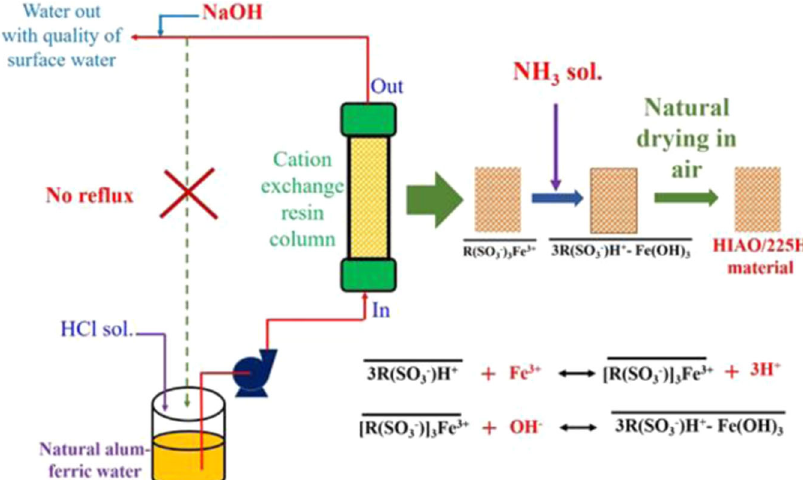
Fig. 8 Process of HIAO/225H material synthesis. A plastic column with a diameter of 1 cm, cation exchange resin: 5 g, adding HCl into the natural alum-ferric water with a dose of 1 mL L − 1 , a fl ow rate of 3 L h − 1 , ammonia solution: 100 mL of deionized water containing 1 mL of ammonia solution (28 – 34 vol%), NaOH solution (0.1